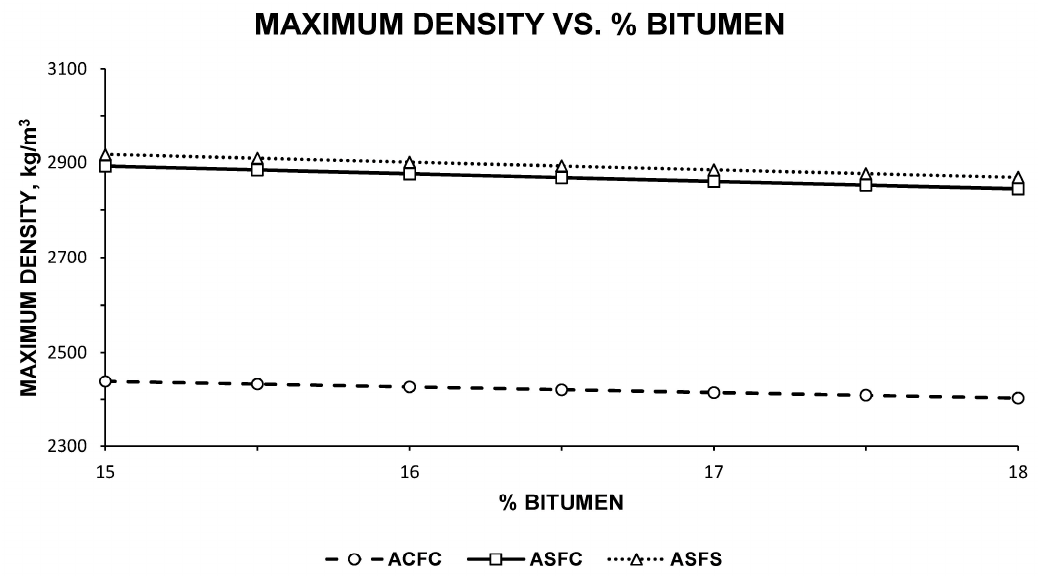
Figure 4. Maximum density of the families of bituminous mixtures ACFC, ASFC and ASFS with different percentages of bitumen in volume of aggregate.